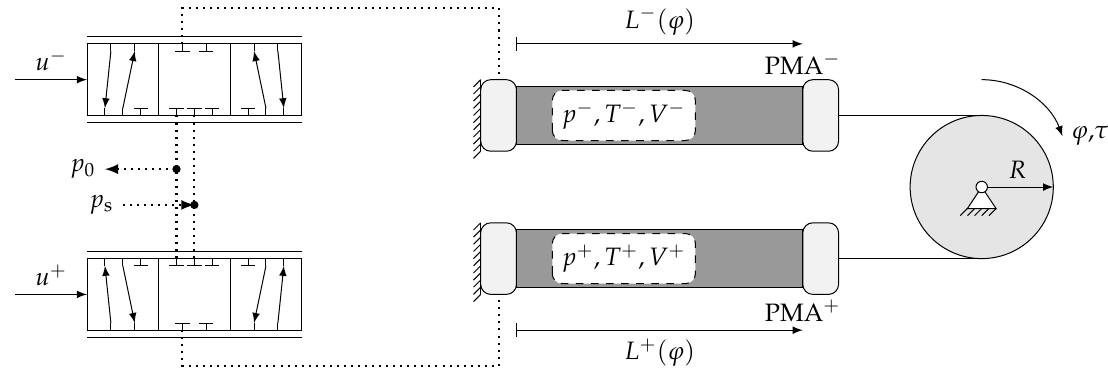
Figure 1. Schematic of a PMA-driven joint.